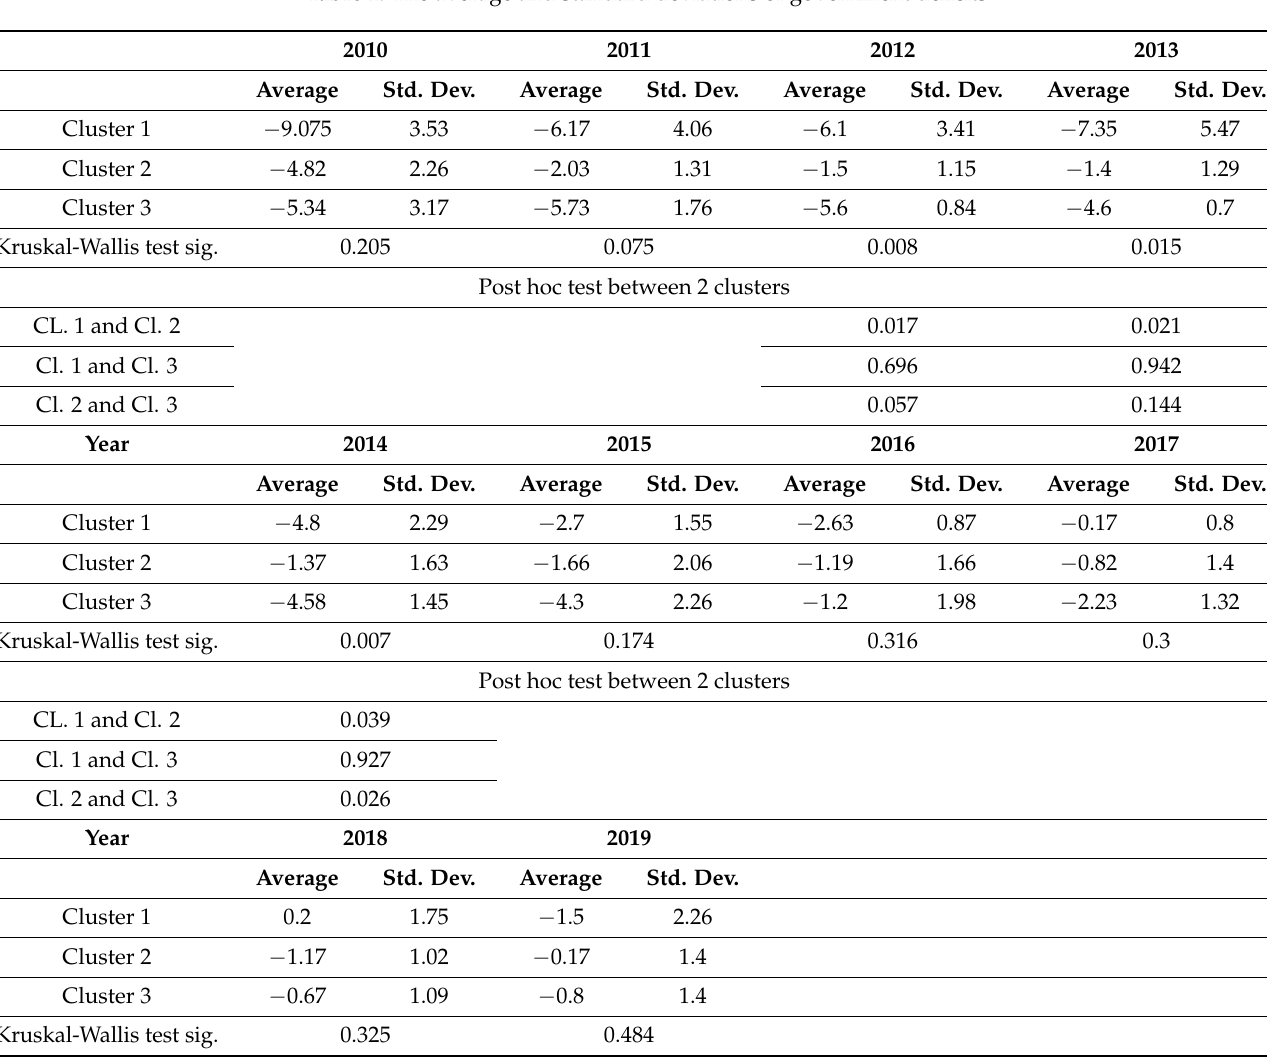
Table 1. The average and standard deviations of government